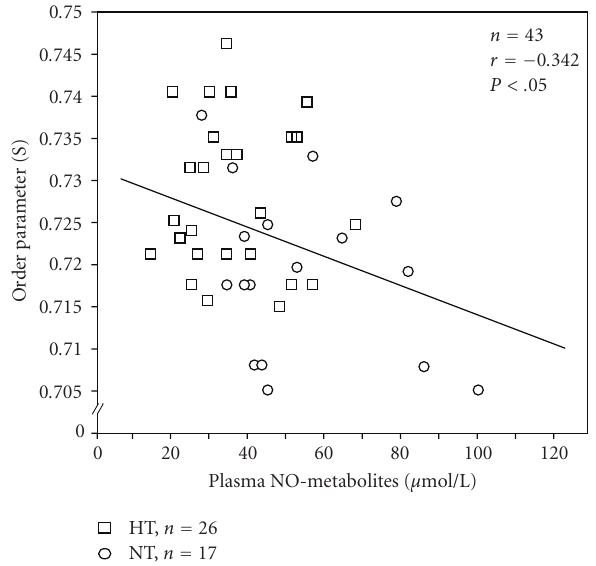
Figure 7: Inverse correlation between plasma nitric oxide (NO) metabolite levels and the order parameter ( S ) of red blood cells (RBCs) in hypertensive and normotensive men.